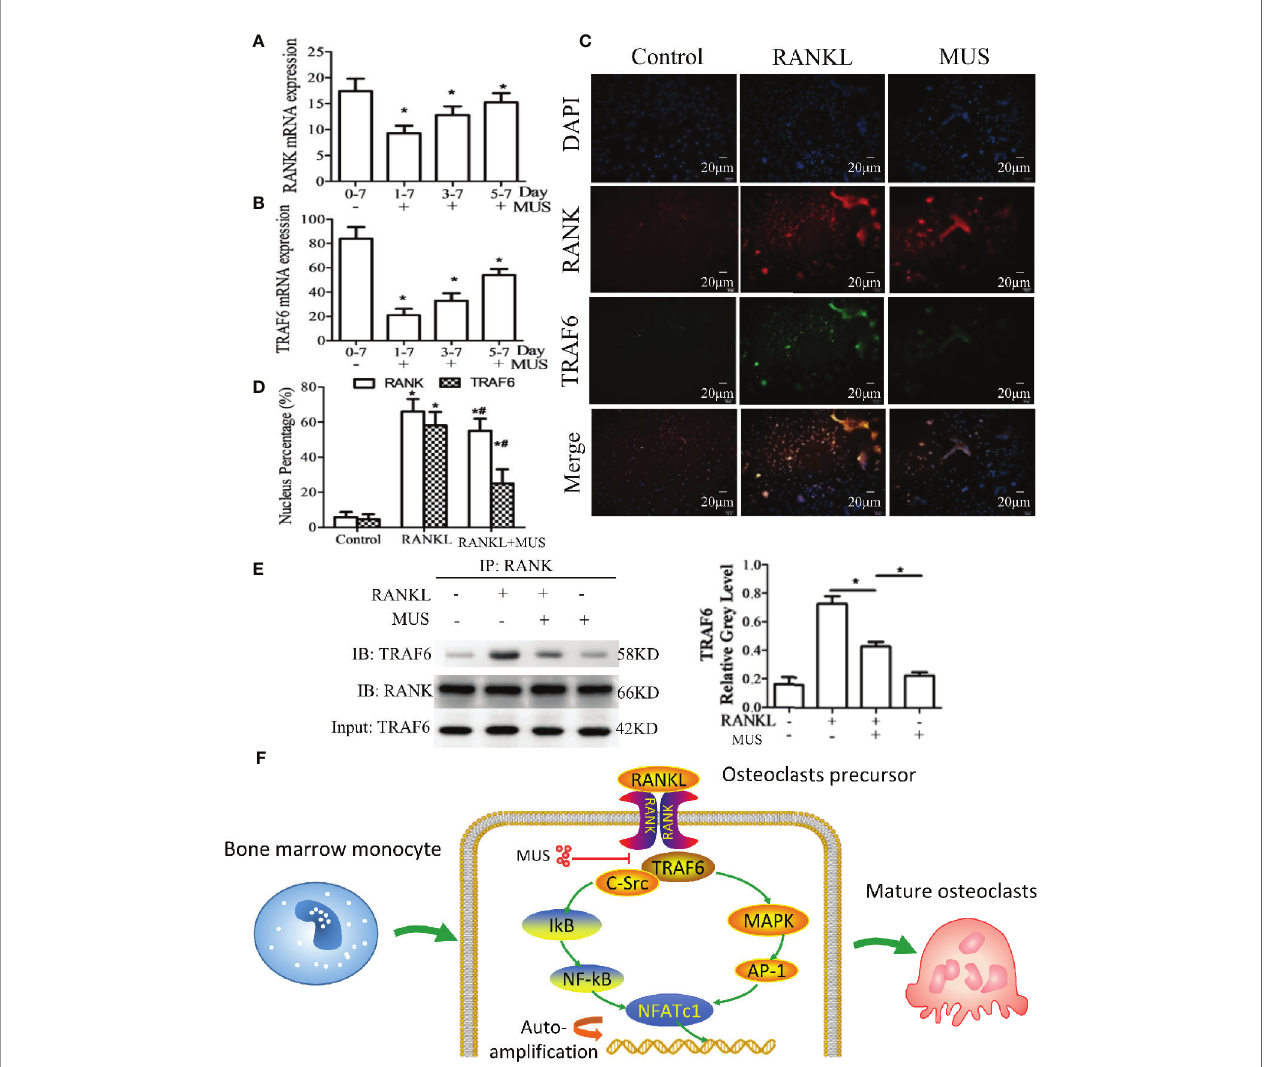
FIGURE 7 | Muscone inhibits RANKL-induced TRAF6 binding to RANK. (A, B) After induction of M-CSF (20 ng/ml) and RANKL (50 ng/ml) on day 0, BMMs and RAW264.7 cells are divided into groups according to the different times that 40 m M muscone is added (day 1-7 group, day 3-7 group, and day 5-7 group, since muscone is added on day 1, 3, and 5, respectively). On day 7, RANK and TRAF6 mRNA expression in BMMs are detected by RT-PCR for each group. (C, D) RAW264.7 cells are stimulated, with or without RANKL (100 ng/ml) for 20 min, and with or without muscone (40 m M) for 6 h. Cells are then subjected to immuno fl uorescence staining. The nucleus percentage counting of immuno fl uorescence staining indicates that muscone signi fi cantly downregulated the expression of TRAF6 protein rather than RANK. (E) To verify the result, coimmunoprecipitation shows that TRAF6 protein levels of RAW264 cells treated with vehicle or muscone (40 m M) with or without RANKL, measured by Western blot analysis. Input: TRAF6 and IB: RANK was used as loading controls. (F) Schematic diagram of the mechanism by which muscone ameliorates RANKL-induced osteoclastogenesis via blocking the binding of TRAF6 to RANK. *P < 0.05 vs. the control group, #P < 0.05 vs. the RANKL-induced